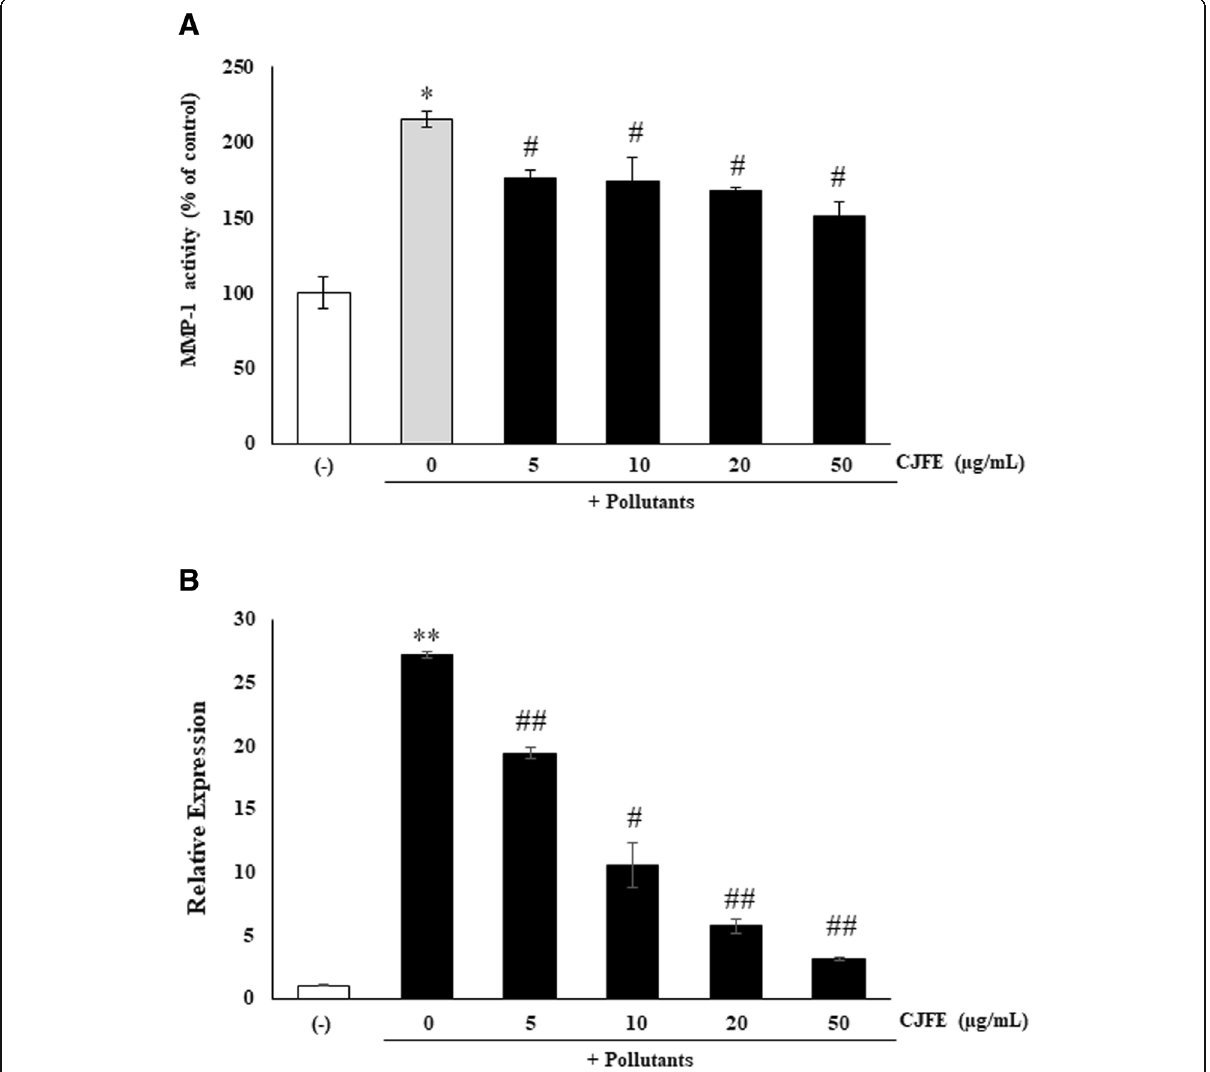
Fig. 4 Anti-pollution effects of CJFE assessed by MMP-1 inhibition ( a ) and quantitative RT-PCR results of urban dust-induced MMP-1 expression in NHDFs ( b ). The results are mean±standard deviation (SD) (n=3). * P <0.05, ** P <0.01 vs. pollutant-untreated control. # P <0.05, ## P <0.01 vs. pollutant-treated